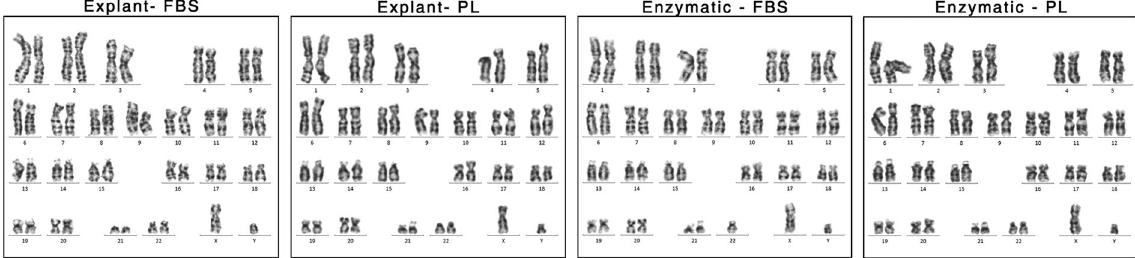
Figure 8. Cytogenetic analysis. Normal Q-banding karyotype obtained from at least 20 proliferating cells of FBS and PL cultured MSC preparations of Passage 4 analyzed revealed a normal 46XY